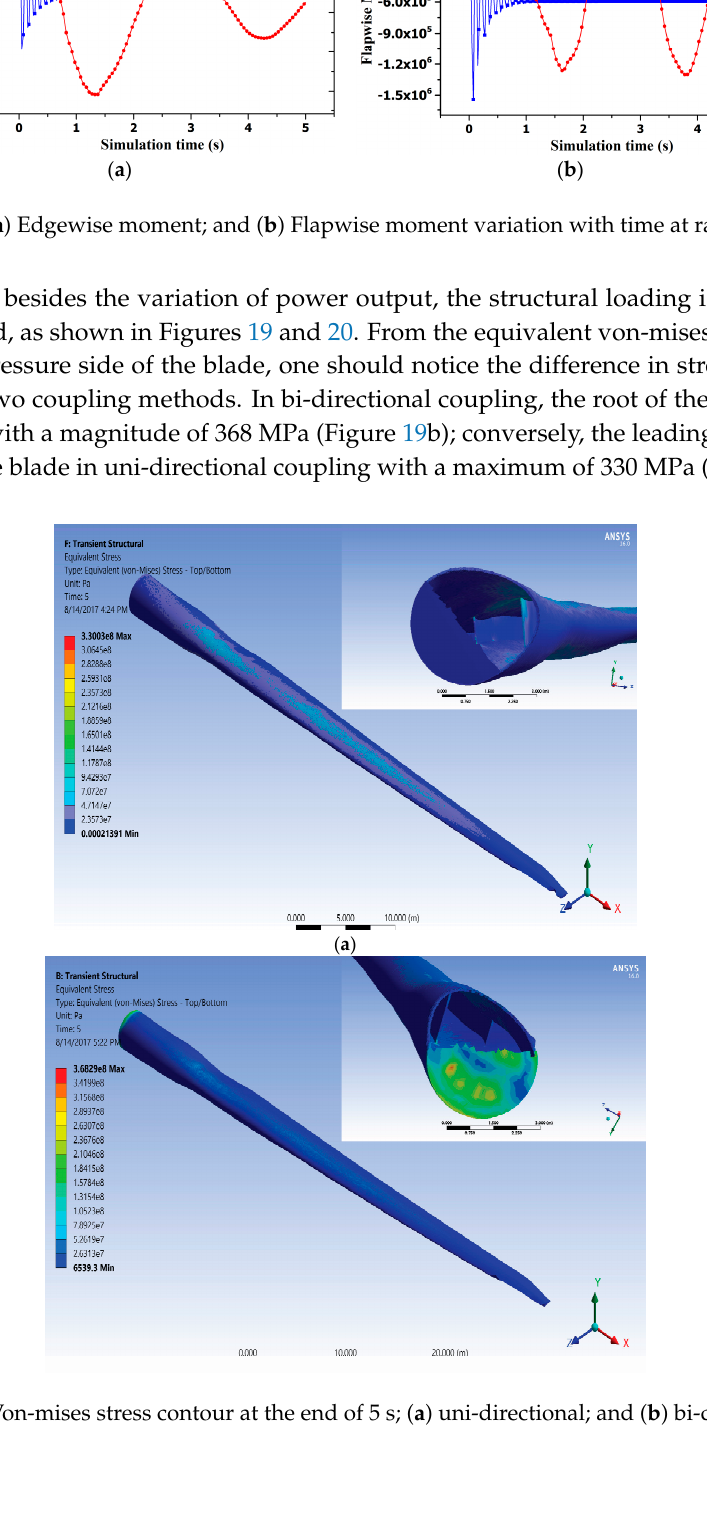
Figure 19. Von-mises stress contour at the end of 5 s; ( a ) uni-directional; and ( b ) bi-directional.